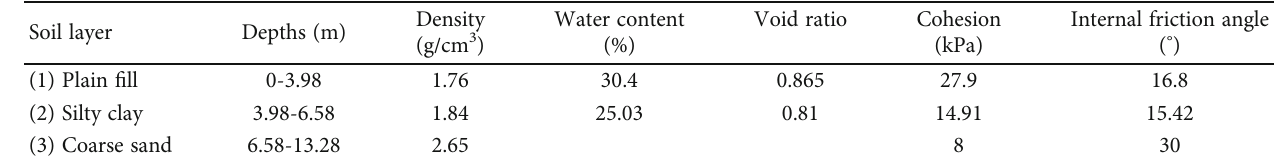
Table 1: Main geotechnical parameters of soils at the construction